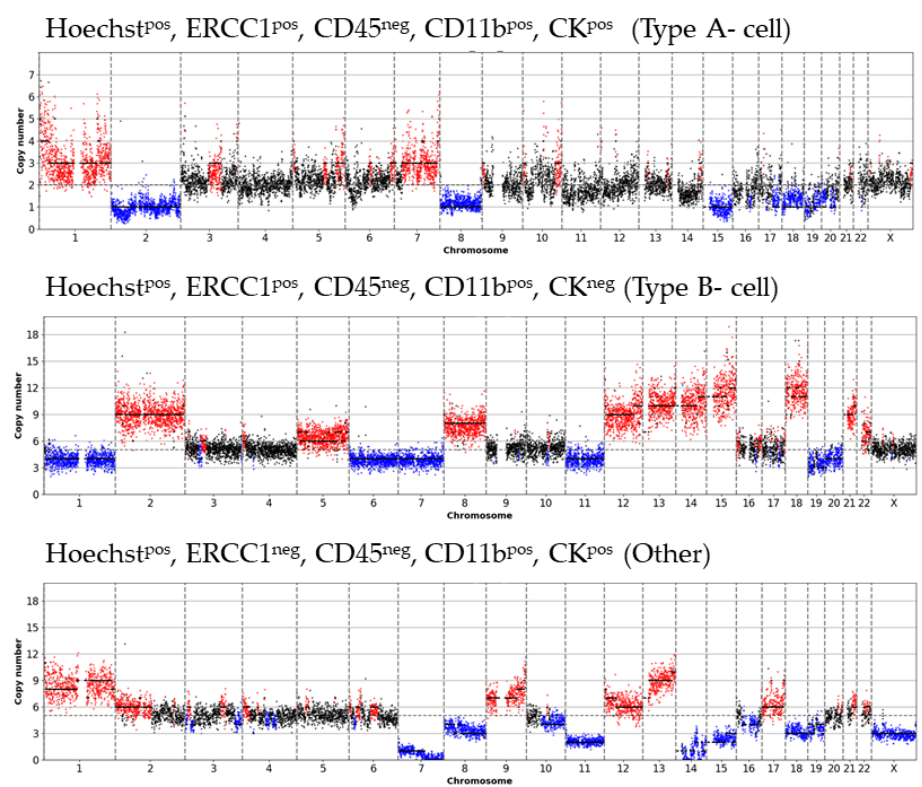
Figure 5. CN profiles of three phenotypic differing sCTCs (patient 11) underlining inta-patient CTC heterogeneity. (1) CN profile of one Type A- cell, Hoechst pos , ERCC1 pos , CD45 neg , CD11b pos , CK pos , (2) CN profile of one Type B- cell, Hoechst pos , ERCC1 pos , CD45 neg , CD11b pos , CK neg and (3) CN profile of one un-defined cell, Hoechst pos , ERCC1 neg , CD45 neg , CD11b pos , CK pos in the same